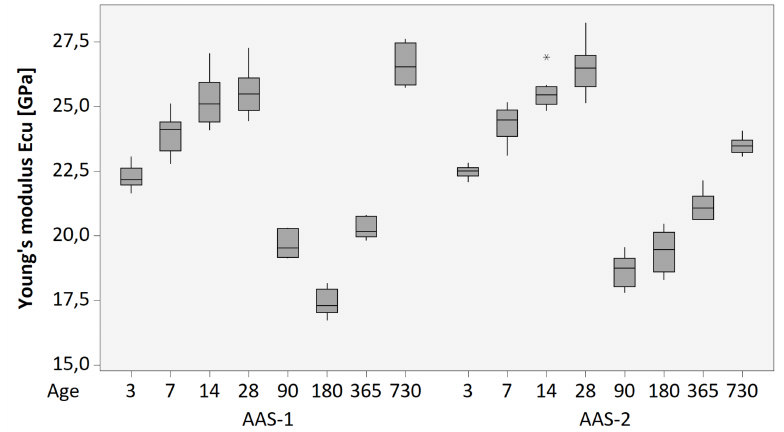
Figure 2. Box plot of the development of the Young’s modulus E